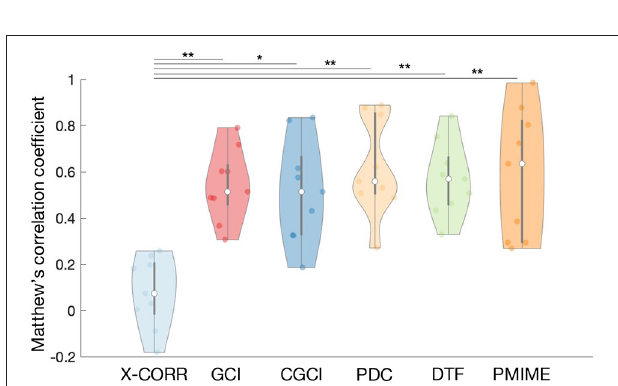
FIGURE 3 | Violin plot of the MCC values for the different causality measures. The white dots and black lines indicate the median and quartile values. The width of the violin illustrates the density of the MCC distribution. Statistically significant differences (one-sided T -test) are annotated with a black line and star (* p < 0.05, ** p <